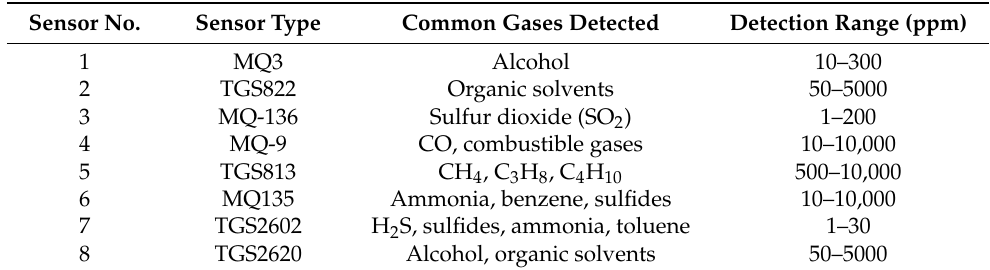
Table 1. Sensor type, chemical class sensitivity, and detection range concentrations for the MOS experimental electronic nose sensor